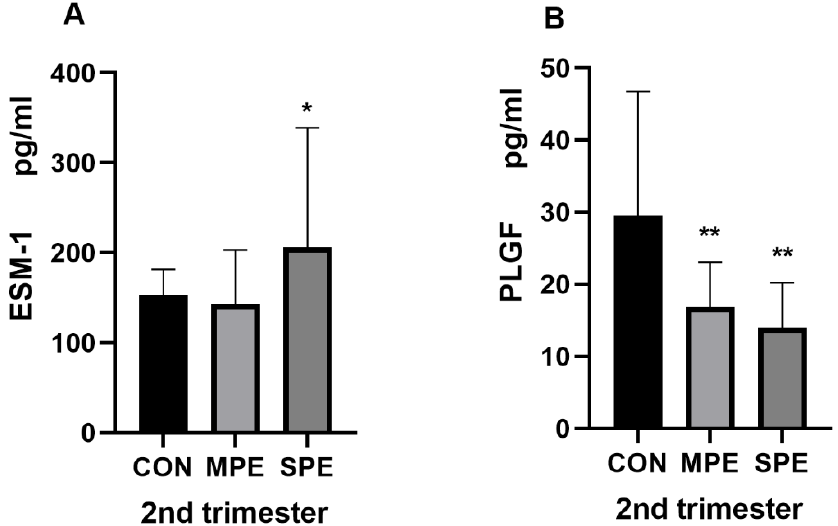
Figure 3. ESM-1 and PLGF in second-trimester maternal serum ( A , B ). CON, n = 60; MPE, n = 18; SPE, n = 33, * p < 0.05, ** p < 0.001.